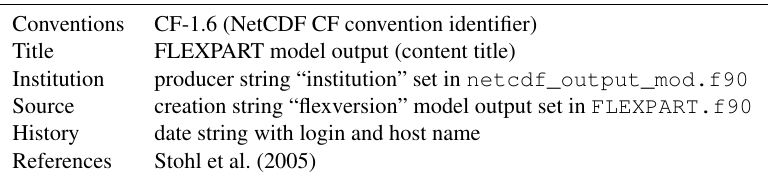
Table 13. Additional information in the NetCDF output file as